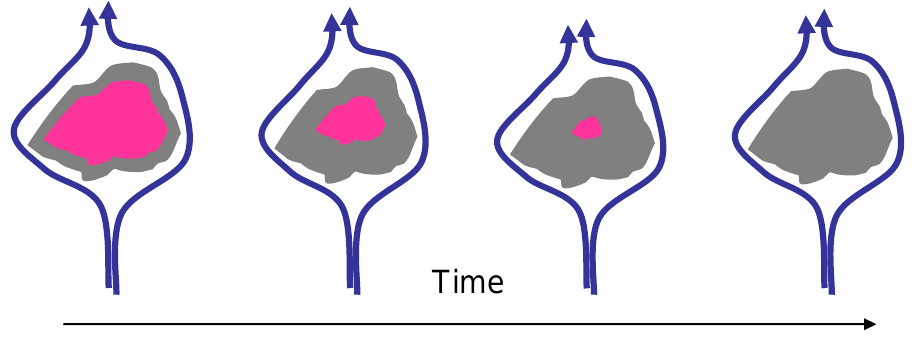
Figure 21. Particle Time History in Moving Bed.